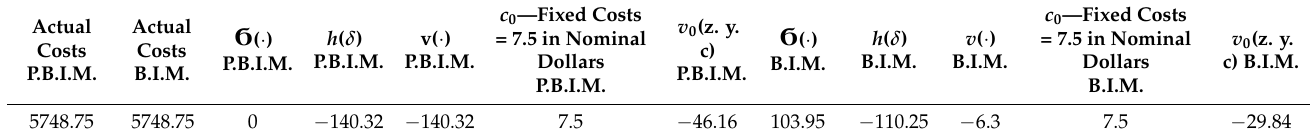
Table 8. Correlation of the Subordinate’s and the Principal’s objective functional using P.B.I.M. with the same parameters of the reward and penalty system. Table 6. The Journal of Experiments, second stage.